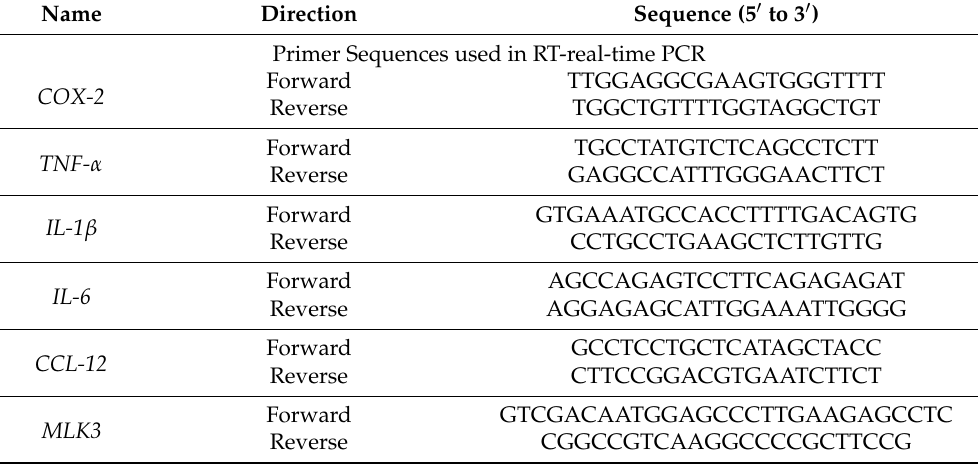
Table 1. Primer sequences for the analysis of mRNA prepared for RT-PCR and real-time